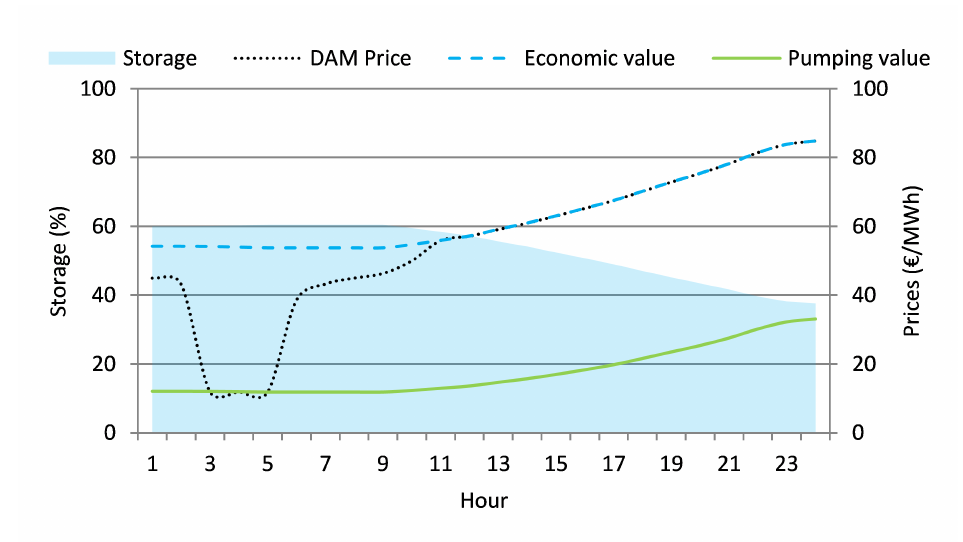
Figure 11. Market prices, water values and dynamic changes in the reservoir